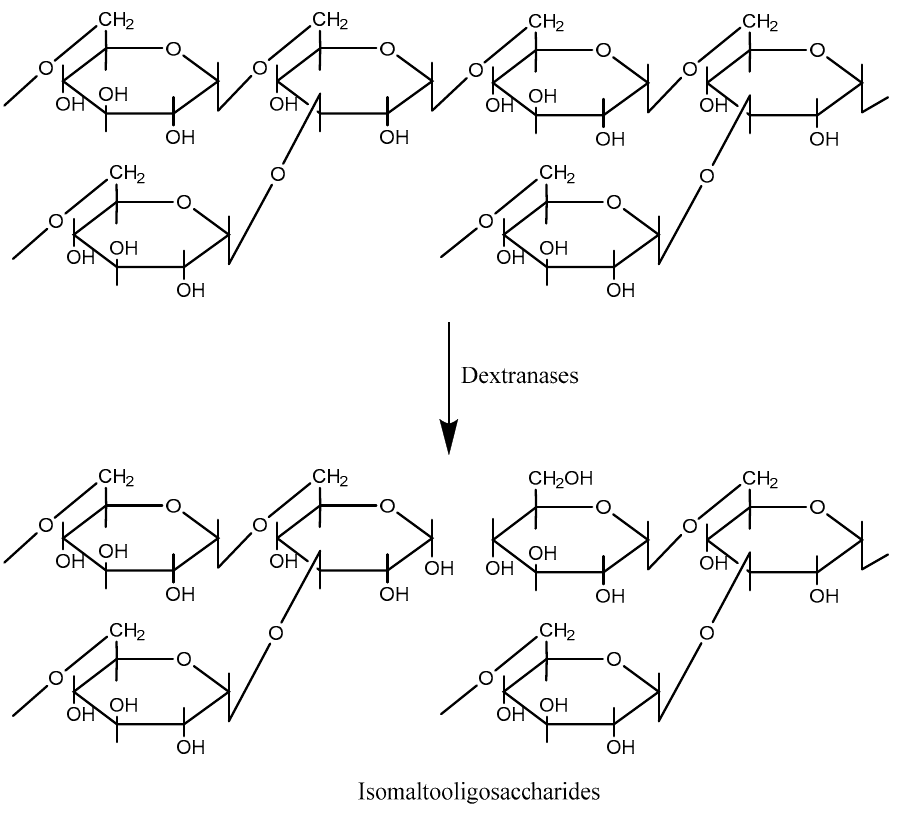
Figure 1. Cleavage of dextran by dextranase.